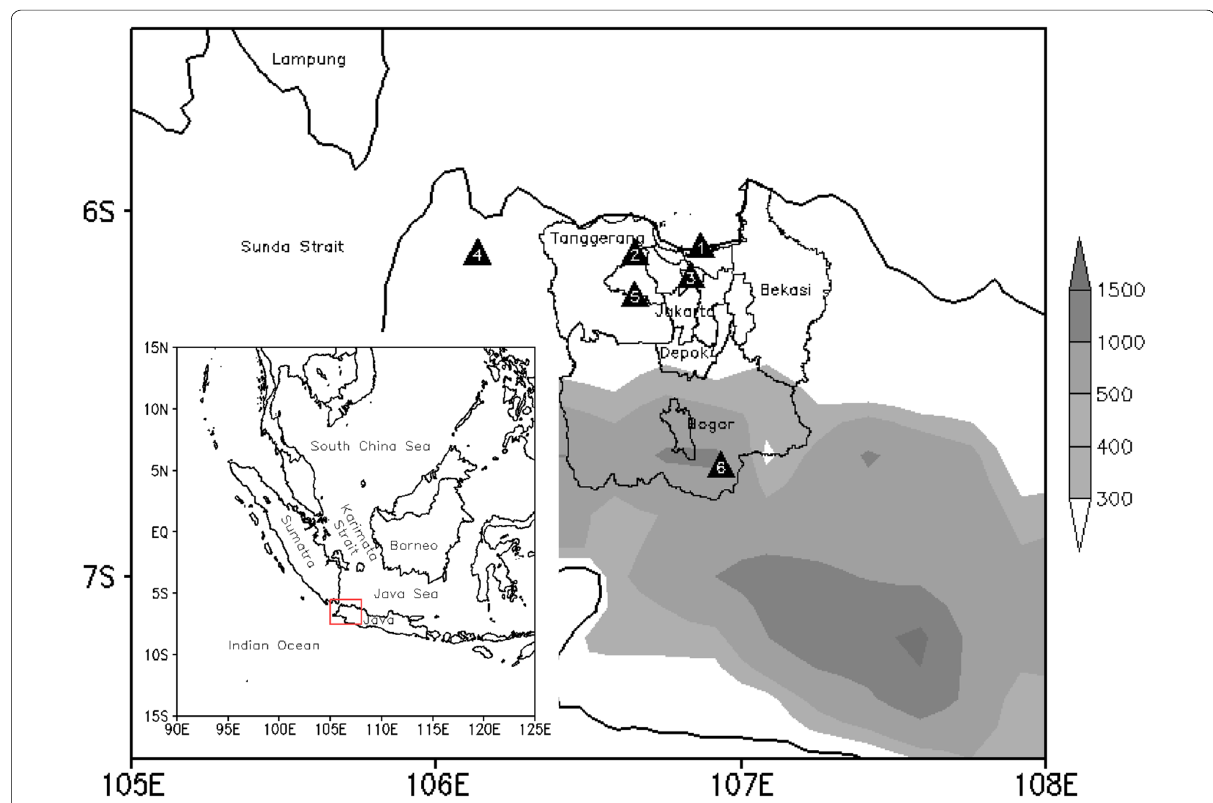
Fig. 1 Area study of the Greater Jakarta as part of Indonesian Maritime Continent. The center of the region is the Greater Jakarta. The numbered triangles are the meteorological stations used in the study, i.e., (1) Port of Tanjung Priok, (2) Soekarno–Hatta Airport Cengkareng, (3) Jakarta Observatory Kemayoran, (4) Serang, (5) Budiarto Airport Curug Tangerang and (6) Citeko Bogor. The shading shows elevations higher than 300